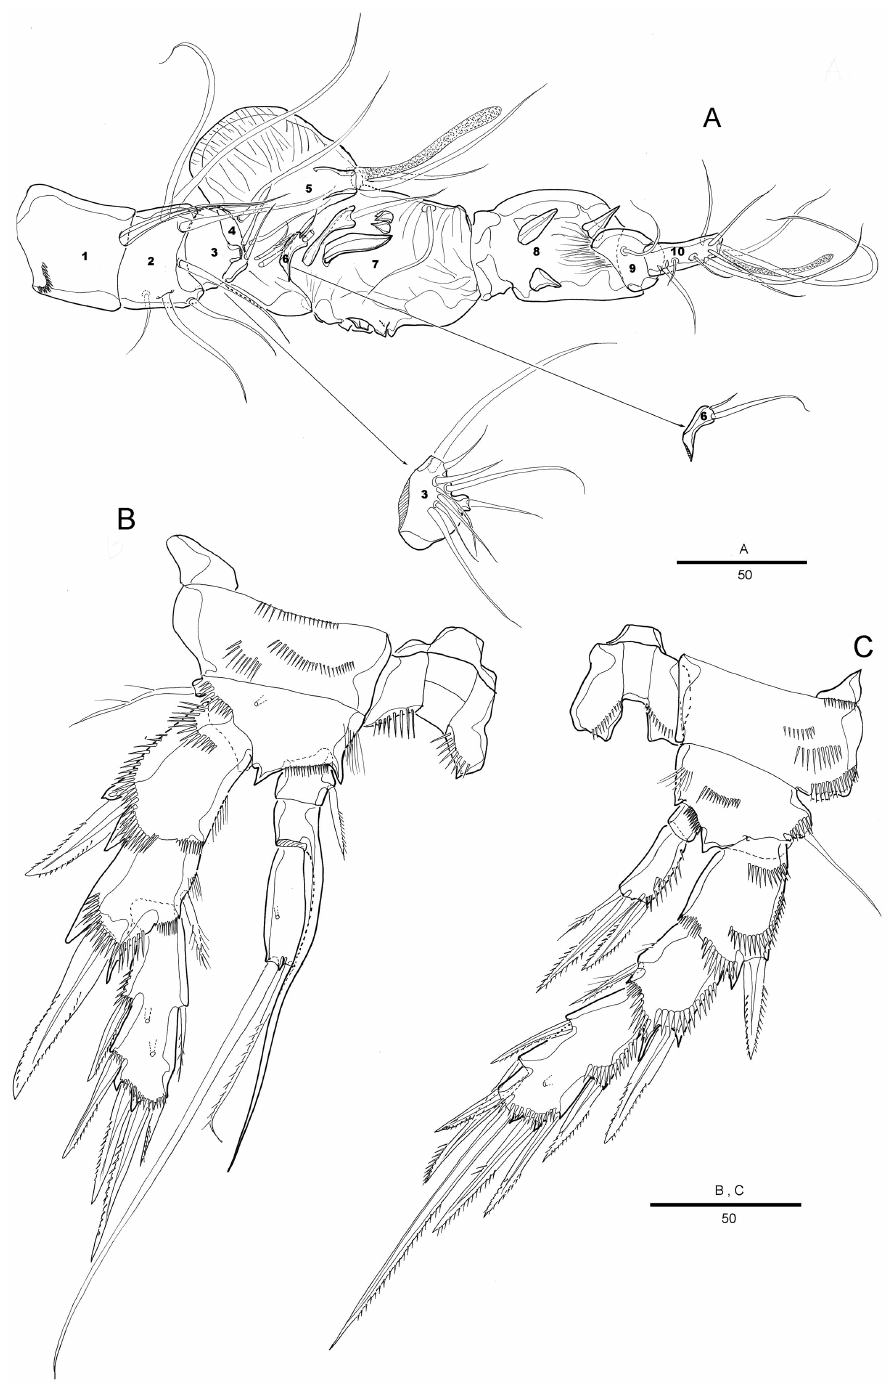
Figure 6. Attheyella ( Attheyella ) tahoensis sp. n. male: A antennule B P3, anterior C P4,